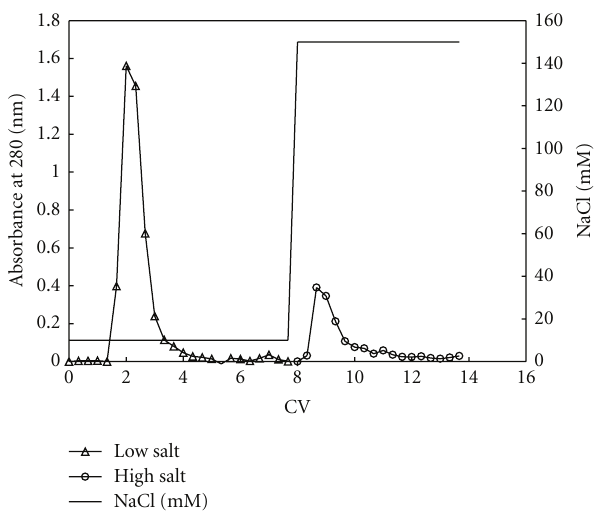
Figure 1: Washing steps for the immunoa ffi nity column. After loading the column was washed with di ff erent salt concentration until no protein was eluted (absorbance at 280